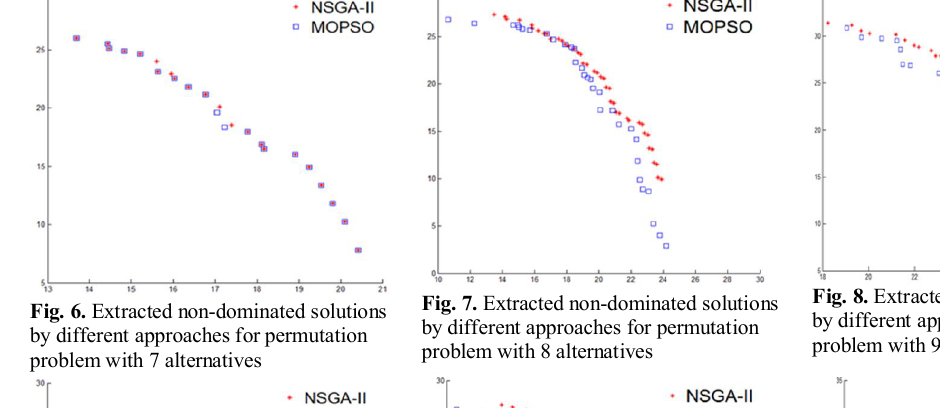
Fig. 7. Extracted non-dominated solutions by different approaches for permutation problem with 8 alternatives